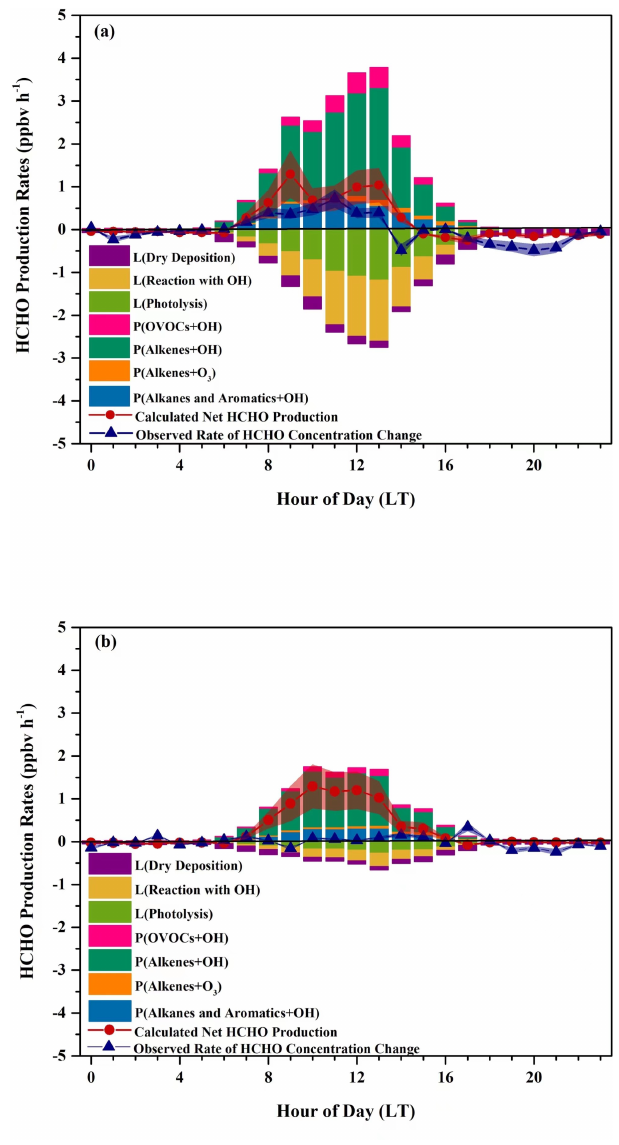
Figure 10. Average diurnal variations in HCHO production rates, HCHO loss rates, the calculated net production rates, and the ob- served rates of HCHO concentration change during (a) the sunny and (b) the cloudy and rainy period. Shaded areas give the uncer- tainties in the calculated net production rates and the observed rates of HCHO concentration